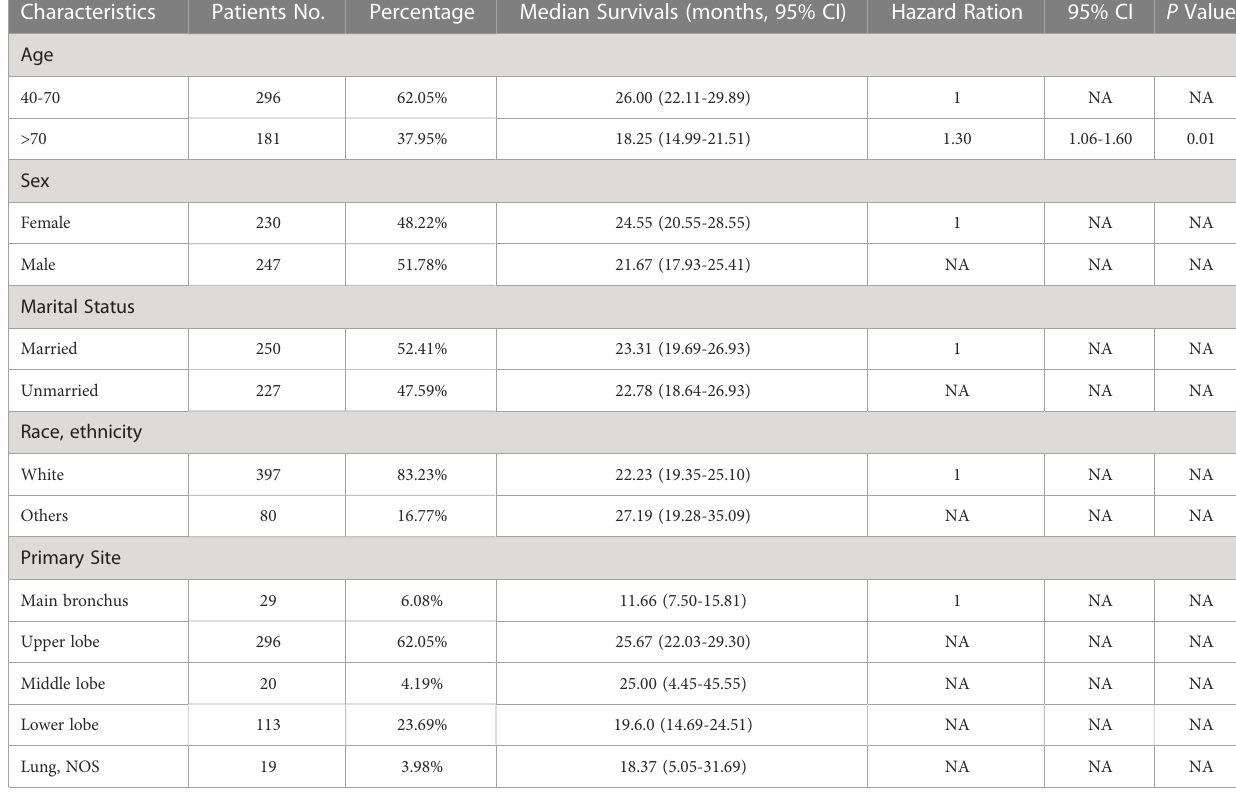
TABLE 1 Demographic variables, median survivals, and multivariable cox regression for patients with C-SCLC.